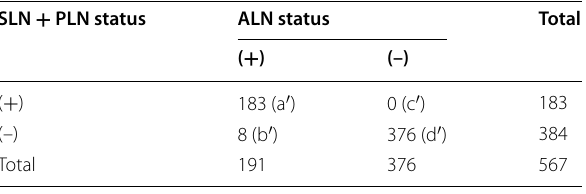
Table 3 ALN metastasis state of 567 patients detected with SLNB and PLN sampling